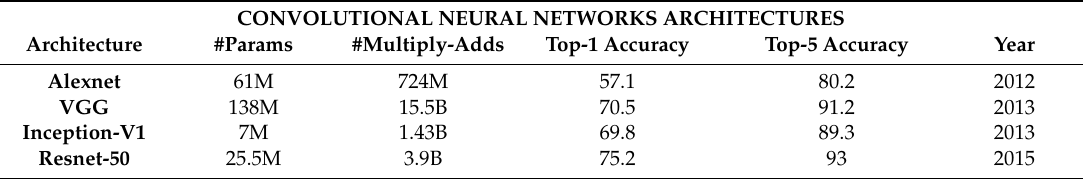
Table 11. Table of comparison for CNN architectures (from ref.